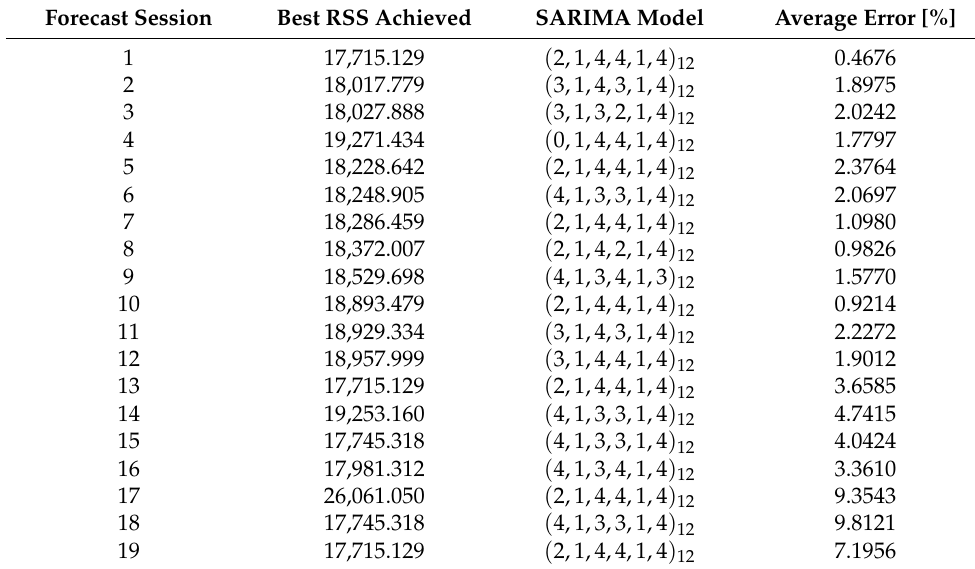
Table 2. Results achieved for each forecasting session.